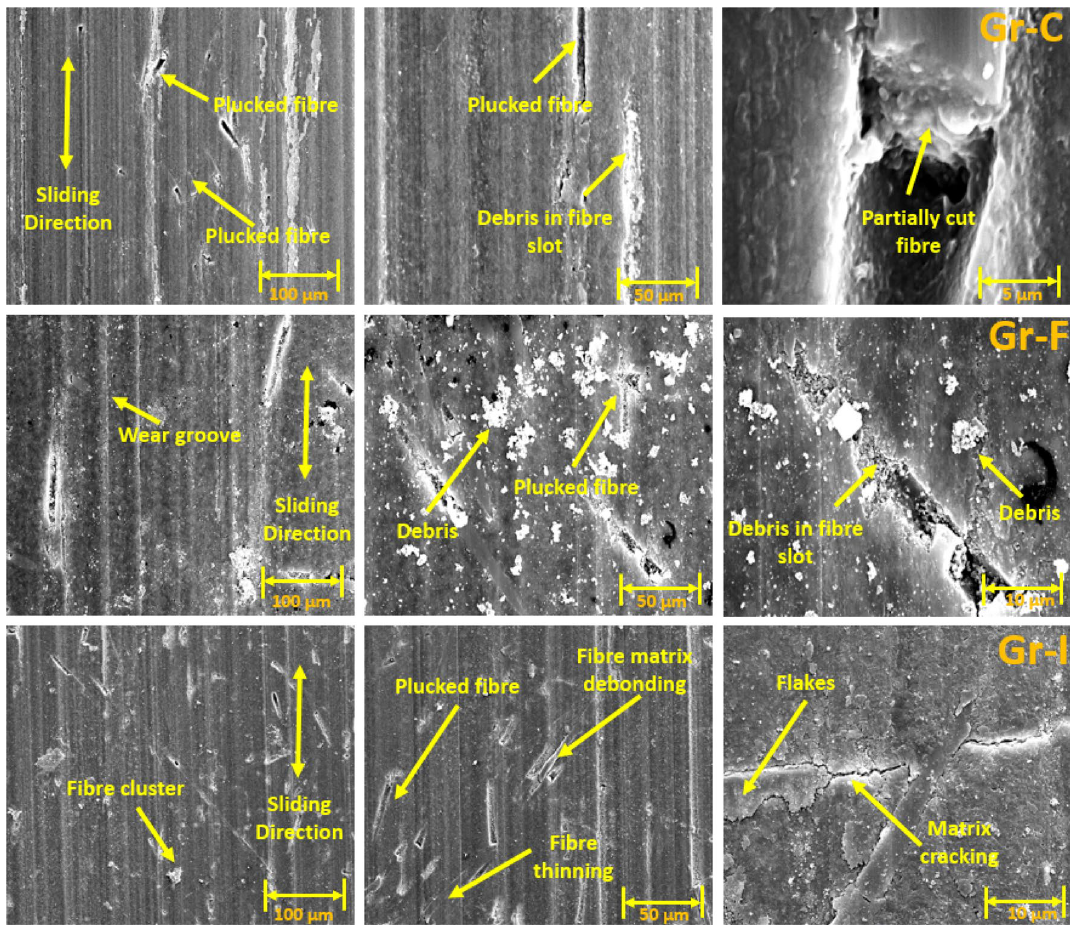
Figure 6. SEM images of 70 AR Group C (5 wt%), Group F (10 wt%) and the Group I (15